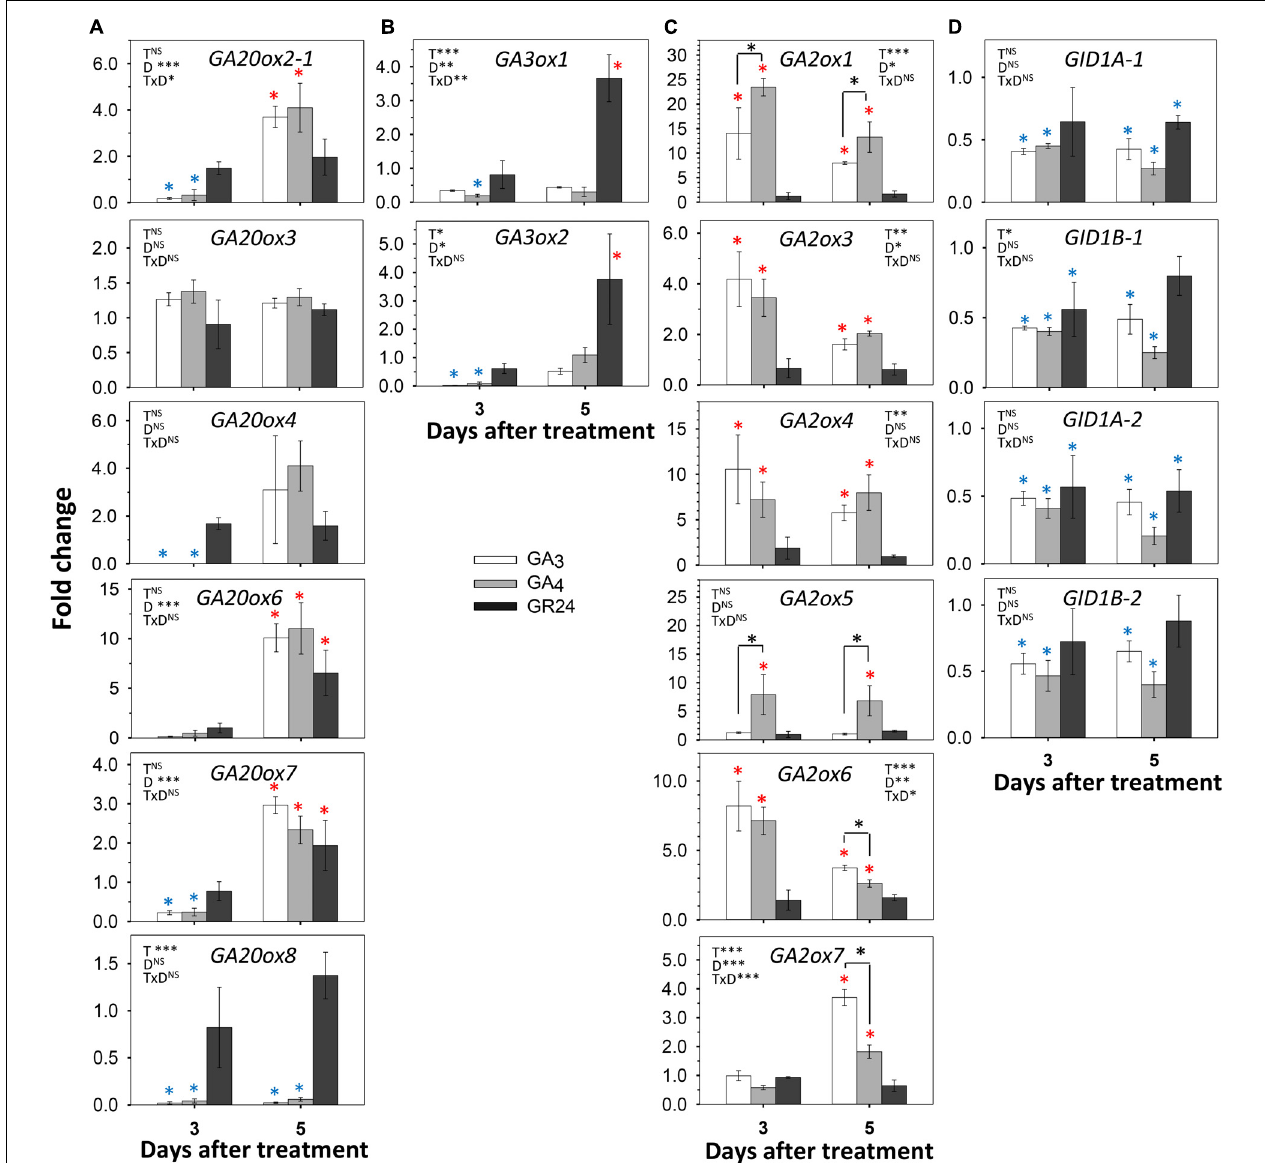
FIGURE 6 | Effect of GA 3 , GA 4 , and GR24 on expression of GA-pathway genes in AXBs. AXBs on single-node cuttings were fed with or without GA 3 , GA 4 and GR24 at a concentration of 10 µ M. (A) GA20-oxidase genes. (B) GA3-oxidase genes. (C) GA2-oxidase genes. (D) GID1 genes. Values are calculated relative to control and represent the means of three biological replicates ± S.E. ( n = six plants). The significance of factors in two-way ANOVA (T, treatments; D, duration in days; TxD, interaction) are indicated by asterisk(s) (* P < 0.05; ** P < 0.01; and *** P < 0.001). Asterisks above the bar indicate decrease (blue) or increase (red), relative to control, and above the hook differences between GA 3 - and GA 4 -treatments (Fischer’s LSD post hoc analysis; P -value at least < 0.05).